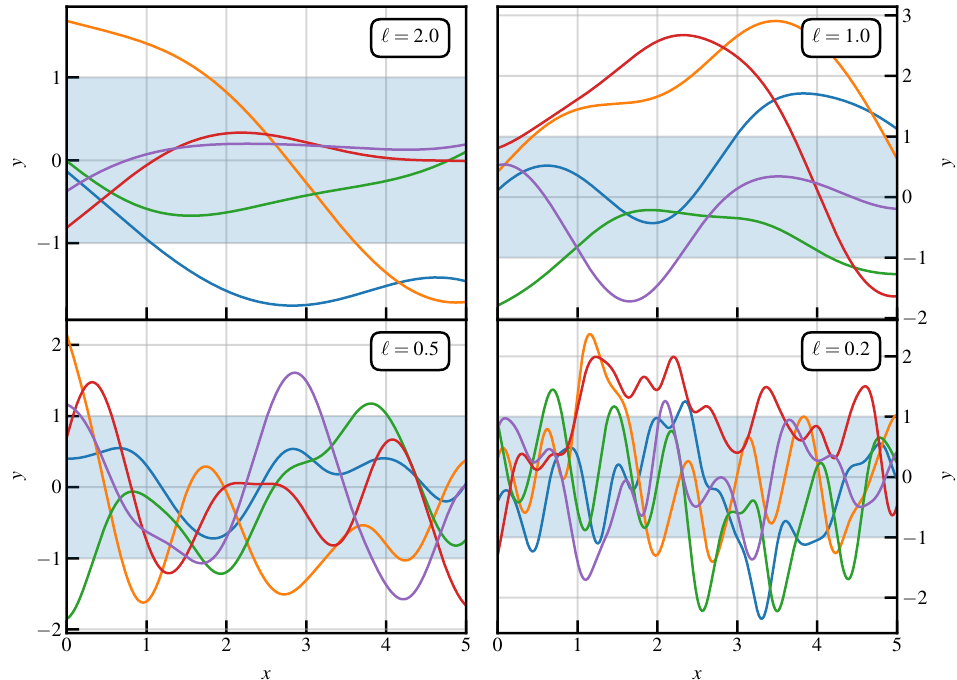
Figure 1. Colours online. Examples of the structure of prior functions for various choices of the (cid:96) parameter. The shaded area represents the 1 σ confidence